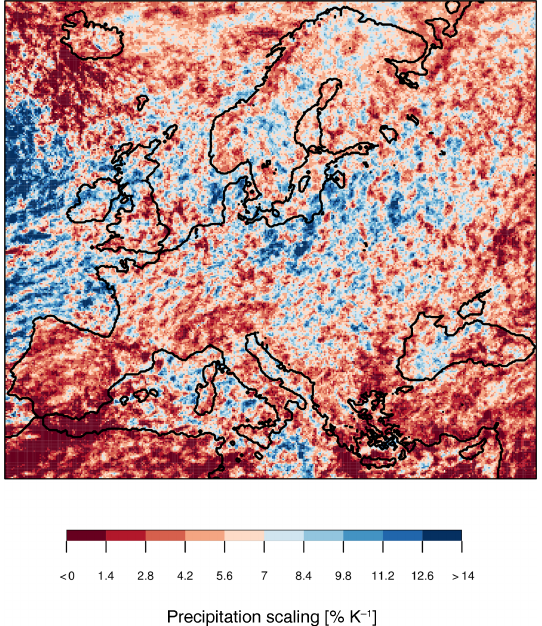
Figure 10. Grand ensemble median of scaling factors (%K − 1 ) for 10-year 12h depths from all models, time slices, and RCPs, calcu- lated separately for each grid